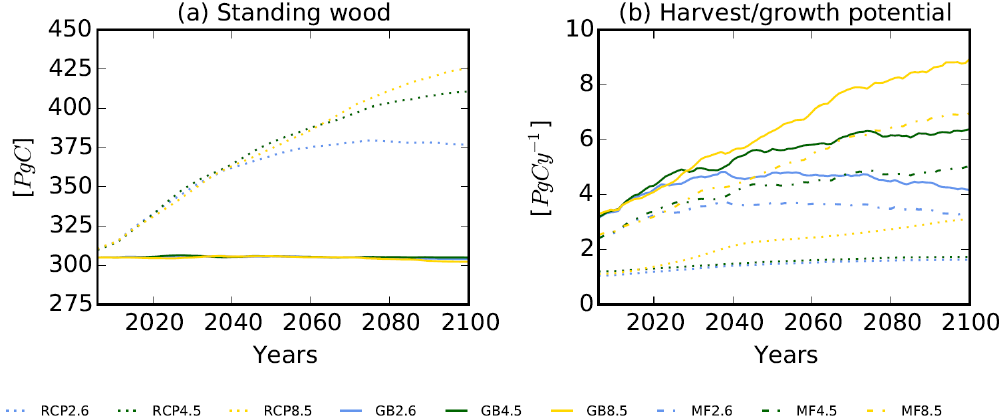
Figure 1. Development of global standing wood carbon pools forced by three different RCP scenarios and subject to the harvesting rules of the Representative Concentration Pathways (RCP2.6, RCP4.5, and RCP8.5) or subject to growth-based harvesting (GB2.6, GB4.5, and GB8.5) ( a ). Development of RCP wood harvest rates, of the growth potential of forests under GB, and of the harvest potential under